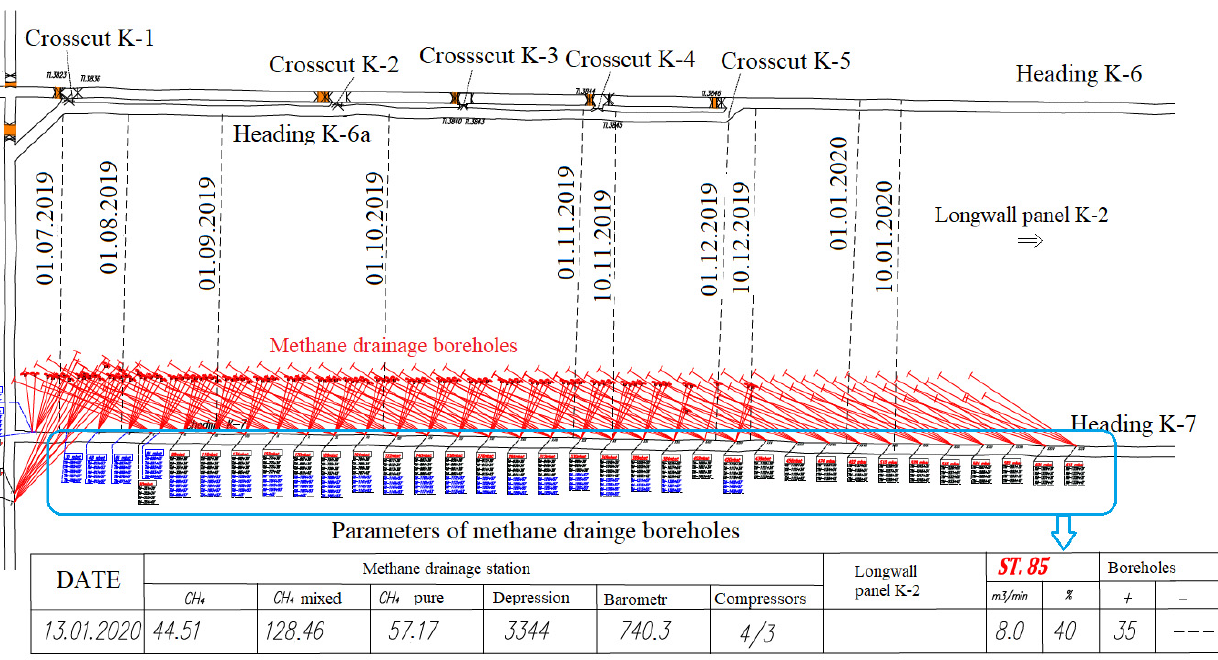
Figure 8. Distribution of methane drainage boreholes along the K-7 heading in the area of the K-2 longwall in the 362 + 363/2 coal seam.